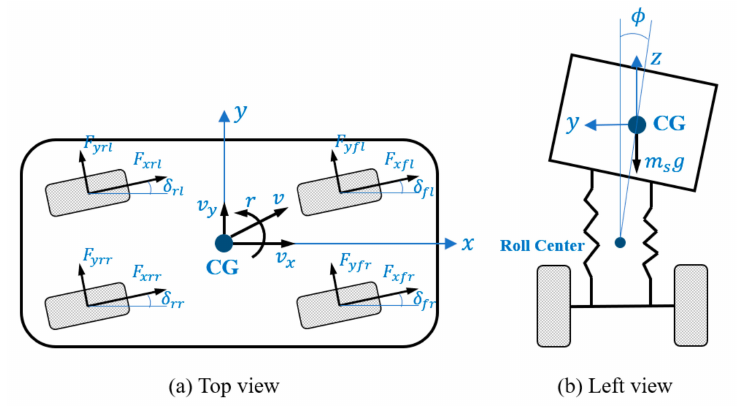
Figure 5. Dynamic model of 4WID-4WIS EV.